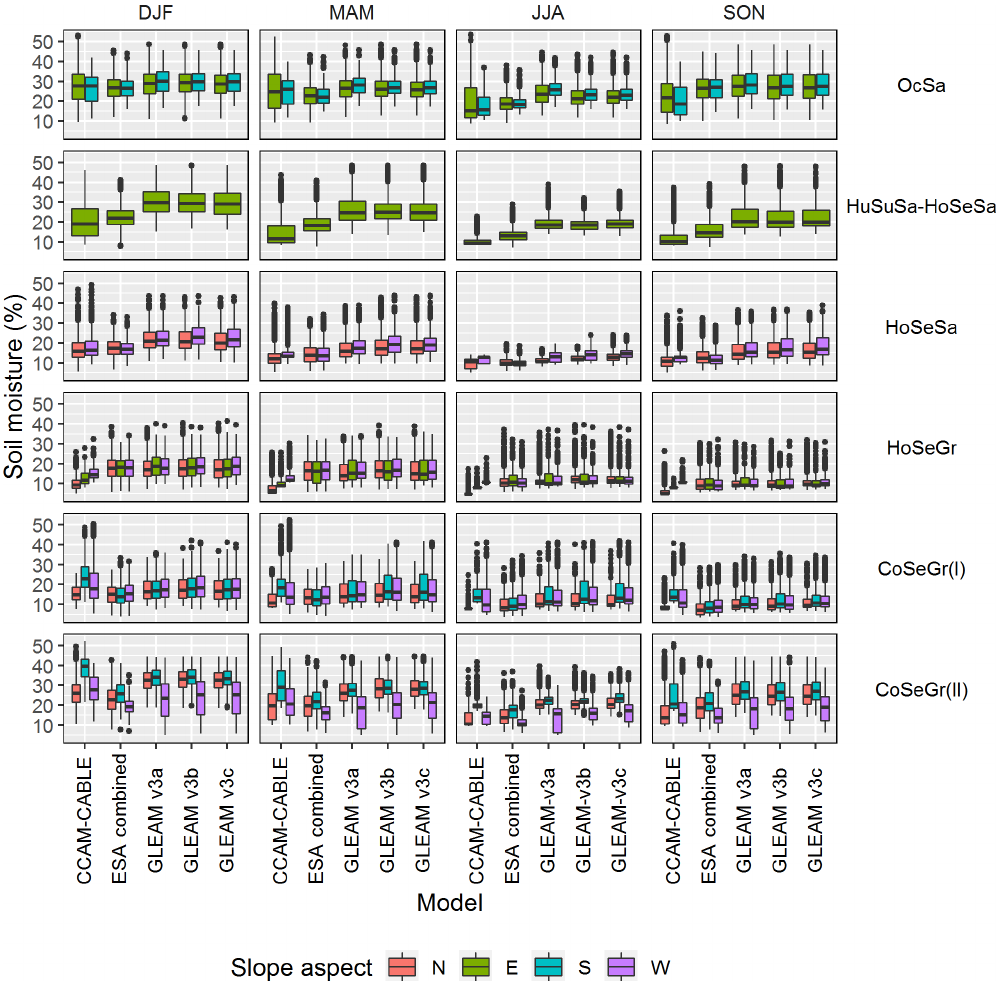
Figure 6. Comparison of modelled soil moisture patterns across sub-regions, namely oceanic savanna (Ocsa), humid subtropical and hot semi-arid savanna (HuSuSa-HoSeSa), hot semi-arid savanna (HoSeSa), hot semi-arid grassland (HoSeGr), and cold semi-arid grassland (CoSeGr). The sub-regions are also based on increasing altitude and slopes of different aspect, i.e. north (N; red), east (E; green), south (S; blue) and west (W; purple). The box plots show the distribution of the seasonal (i.e. summer, DJF; autumn, MAM; winter, JJA; and spring, SON) soil moisture data points per model within the respective regions. Each of the sub-regions consist of 16 grid cells for various slope aspects; therefore, each box plot contains 30 data points for each month of the 3-month season for the 4-year period (2011–2014) for each product and slope aspect, i.e. n = SP · 3 ( 30 ) · 4, where SP is the number of points for each slope